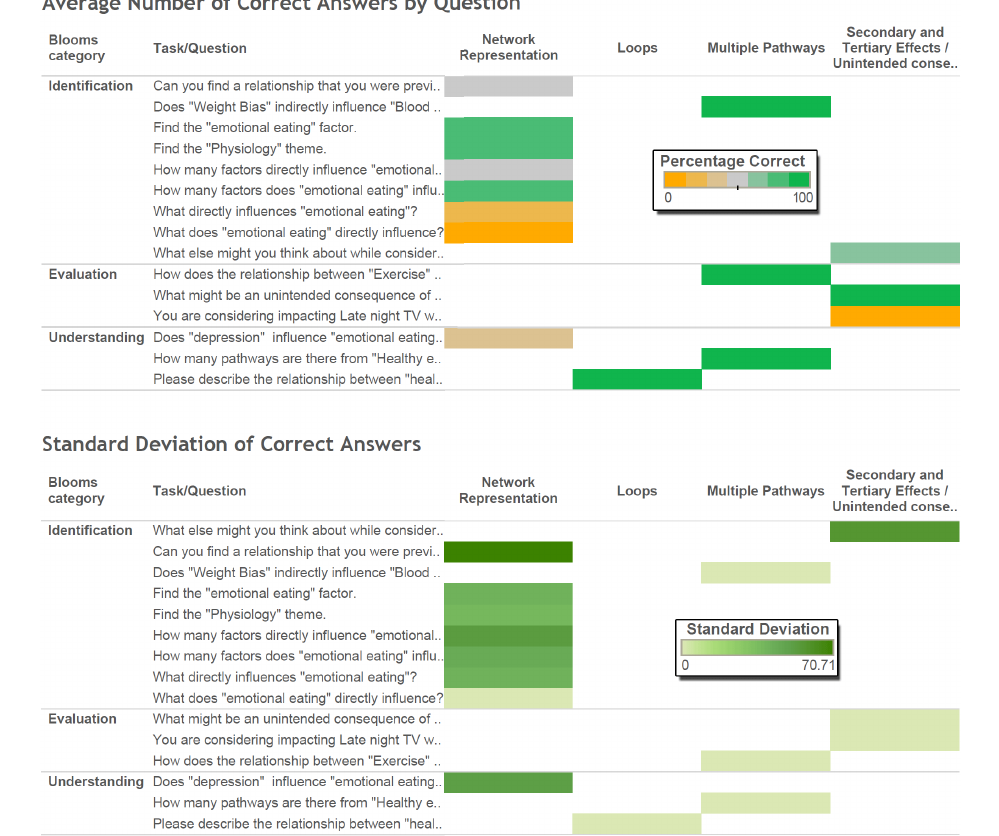
14 of 30 Figure 7. Correct (green) or incorrect (orange) answers for each user and task.